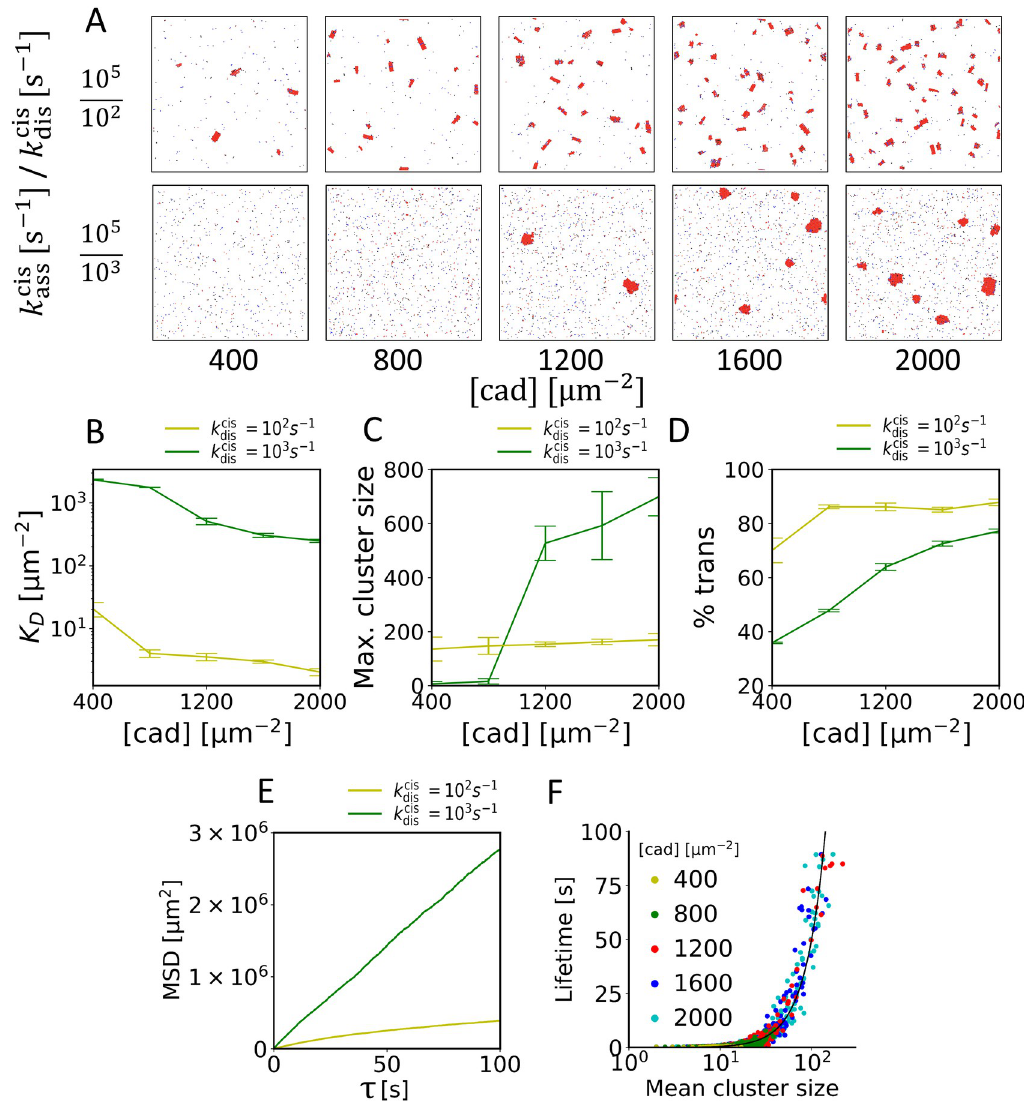
Fig 2. Weak cis binding affinity leads to formation of larger clusters. (A) Snapshots of simulations at 100 s with k cis 1000 (1 st row) and 100 (2 nd row) and different cadherin concentration, [cad]. (B-D) Comparisons of (B) the cis dissociation constant K cis , (C) maximum cluster size at 100s, and (D) the fraction of cadherin molecules existing as trans dimer measured in D simulations shown in (A). (E) Mean squared displacement (MSD) of cadherin monomers measured in two simulations shown in the rightmost column of (A) [cad] = 2000 μ m -2 . Each data point in (B-E) represents the average of data obtained in 5 simulations performed under the same condition. (F) Lifetime of clusters measured in all 5 simulations shown in 2 nd row of (A). A solid black line indicates a quadratical increase in the cluster lifetime, ~[cad] 2 . The cluster size is defined as the number of monomers in a